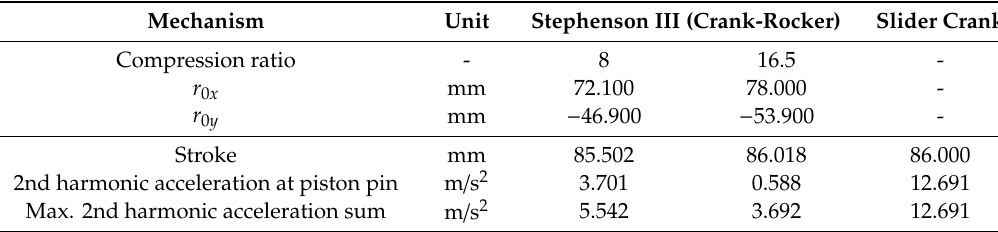
Figure 14. Stephenson III VCR engine mechanisms with double-crank type four-bar linkage. Table 9. Vertical second harmonic acceleration components in the finally designed single-cylinder Stephenson III with crank-rocker four bar at low and high compression ratios.